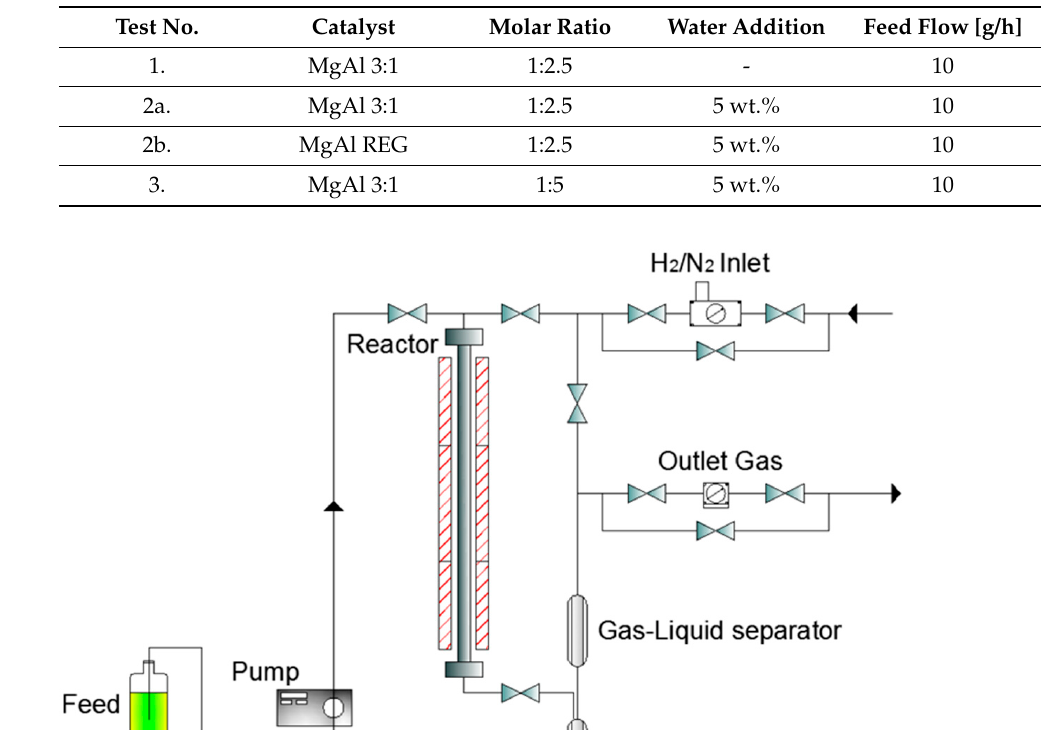
5 of 15 Table 1. The reactions overview of F:Ac experiment in flow-through experiment . Test